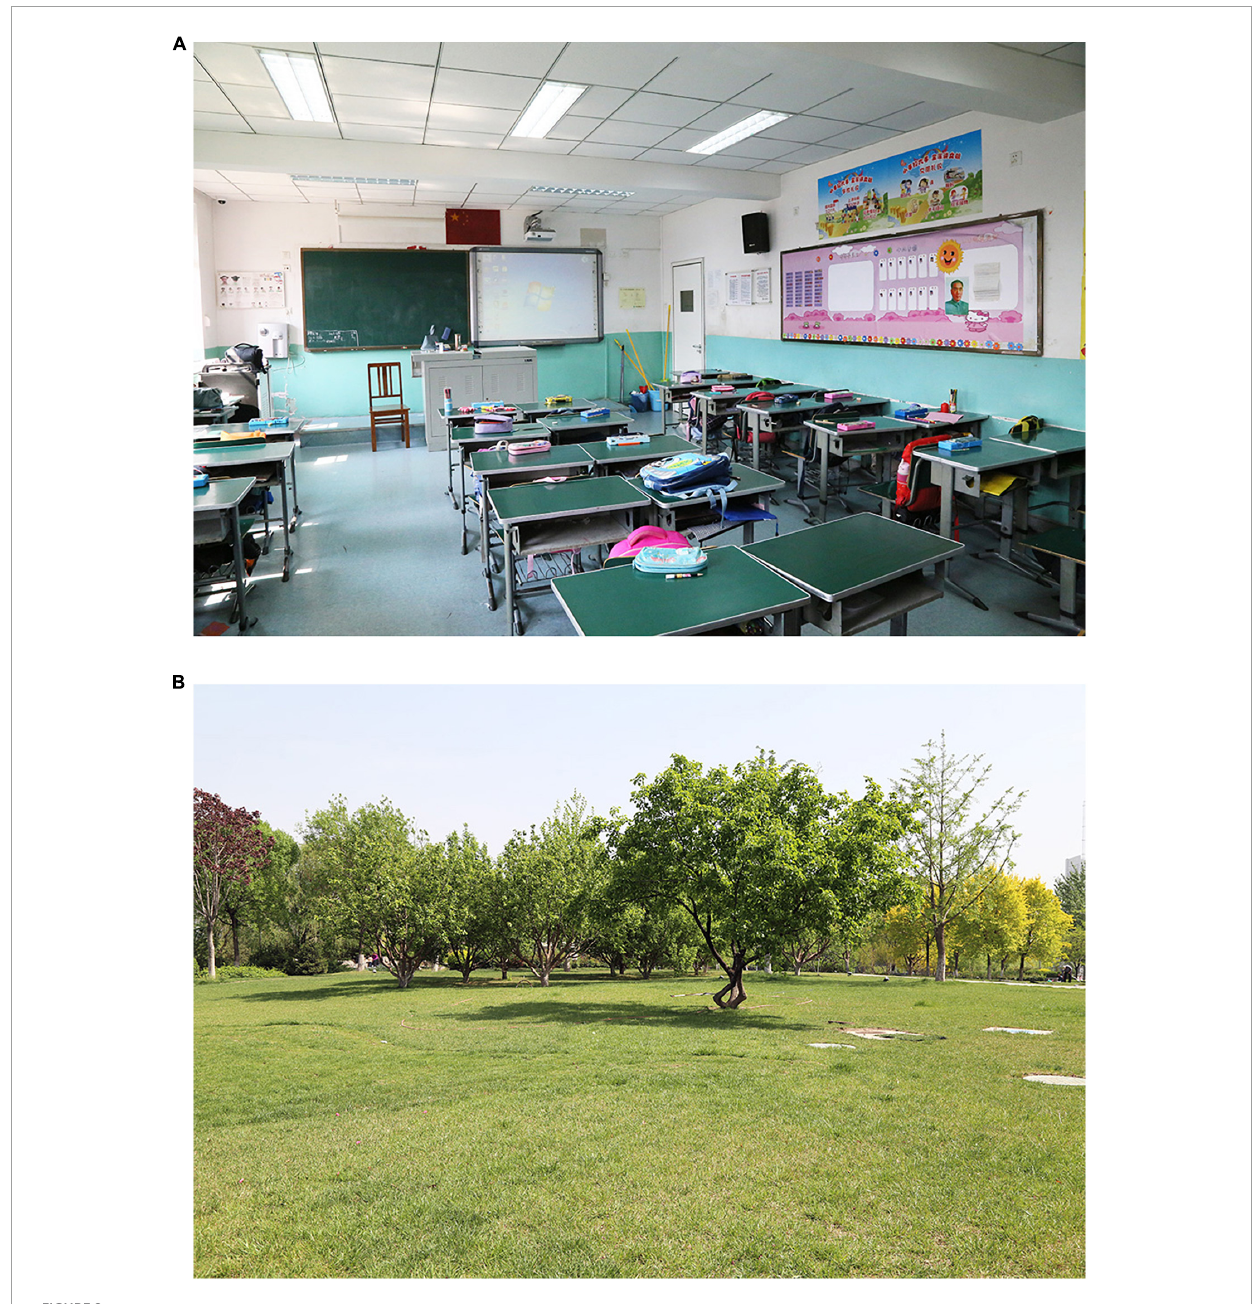
FIGURE2 The visual contexts of a classroom (A) and an urban park (B)